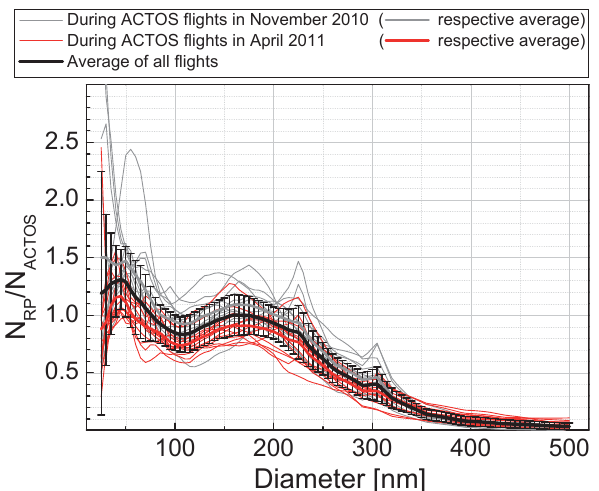
Figure A2. Impaction efficiency of the cyclone, i.e., the size- dependent fraction of particles passing the cyclone ( f passing ). The grey dots result from calibration measurements done in our home laboratory with dry size-selected ammonium sulfate particles; the grey line is the respective fit. The red lines originate from this fit when it is assumed that particles were hygroscopically grown while passing the cyclone and were dried only afterwards. Data shown in black are the same as in Fig. A1, i.e., N RP /N ACTOS .